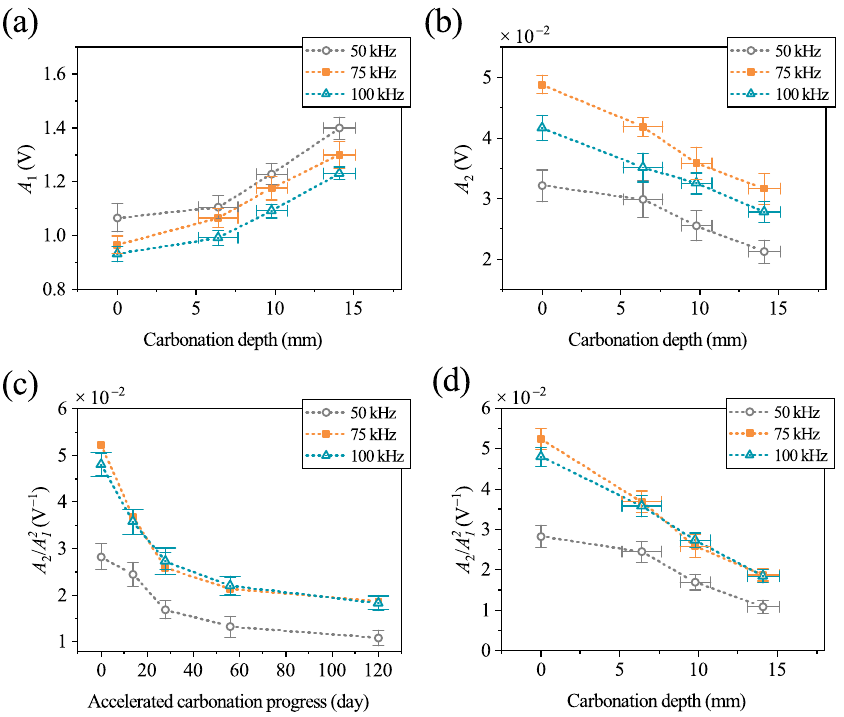
Figure 8. Fundamental amplitudes, harmonic amplitudes and non-linear parameters of excitation signals at various